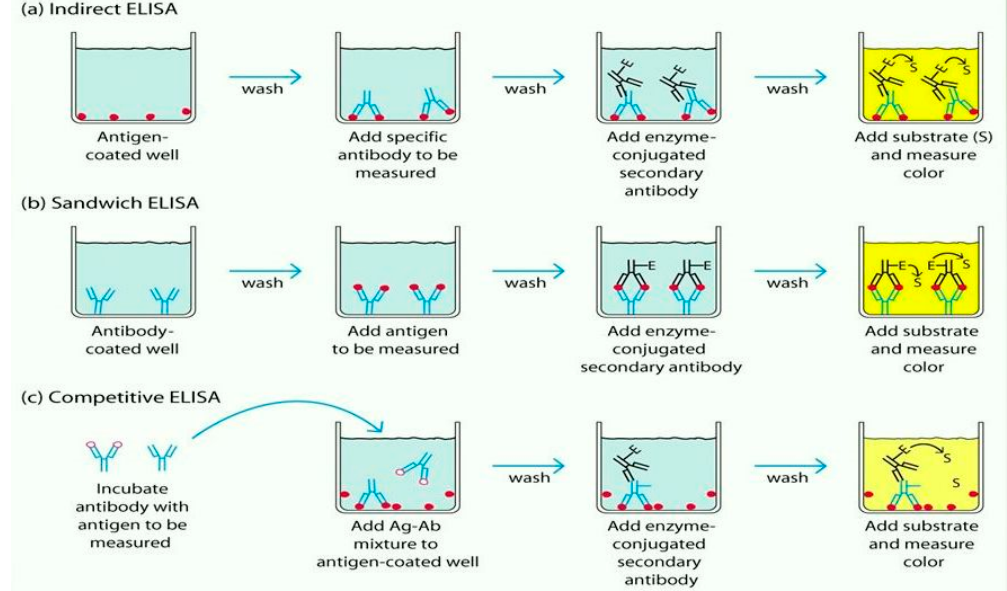
Figure 2. Immunology-based technique using indirect ELISA, sandwich ELISA, and competitive ELISA through schematic diagrams.